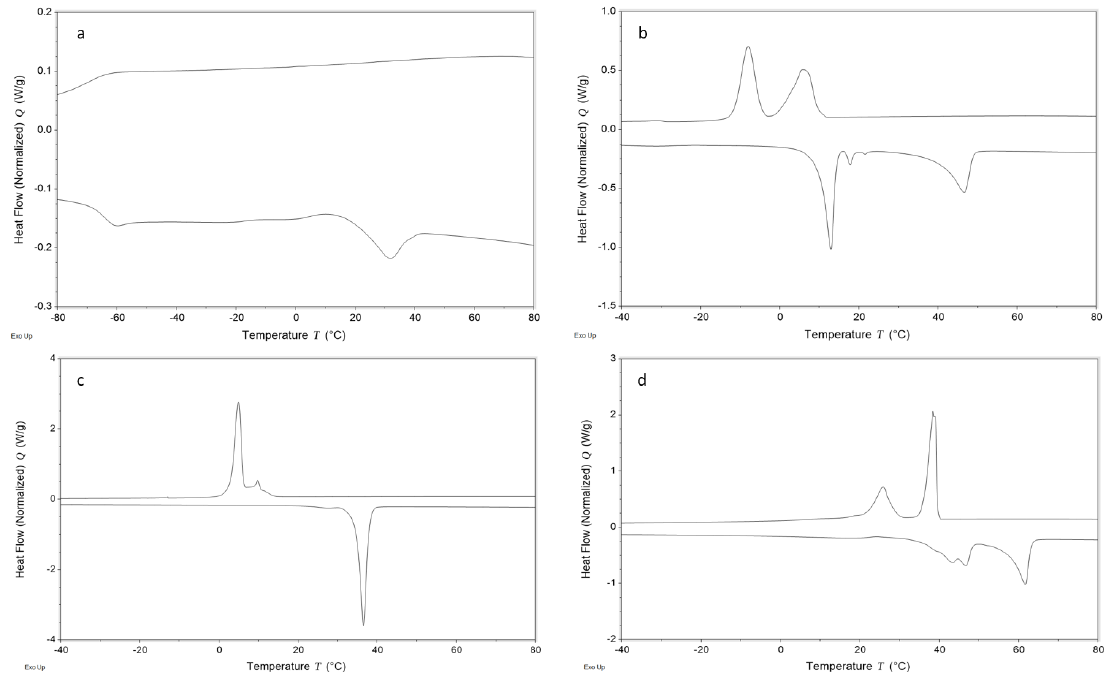
ff erential scanning calorimetry (DSC) of C Figure 2. Differential scanning calorimetry (DSC) of C 7 CO-HTMG ( a ), C 9 CO-HTMG ( b ), Figure 2. Di ( c ), and C 13 CO-HTMG ( d ), at a scanning rate of 5 ◦ C /